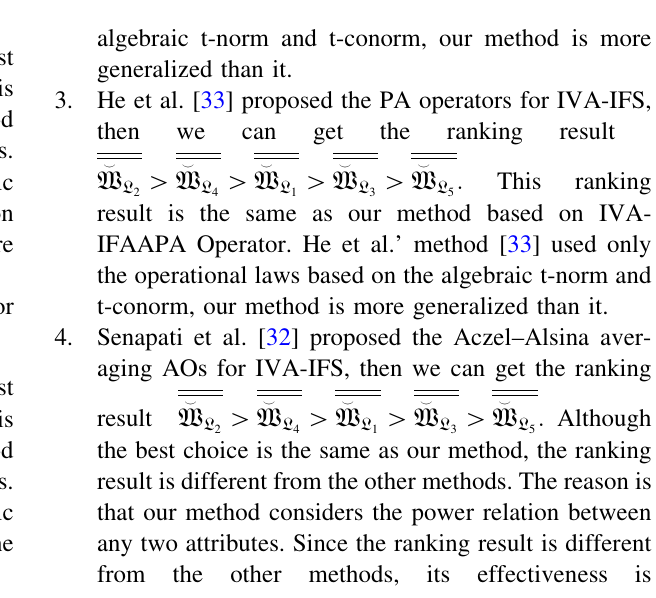
Intuitionistic fuzzy sets Interval-valued intuitionistic fuzzy